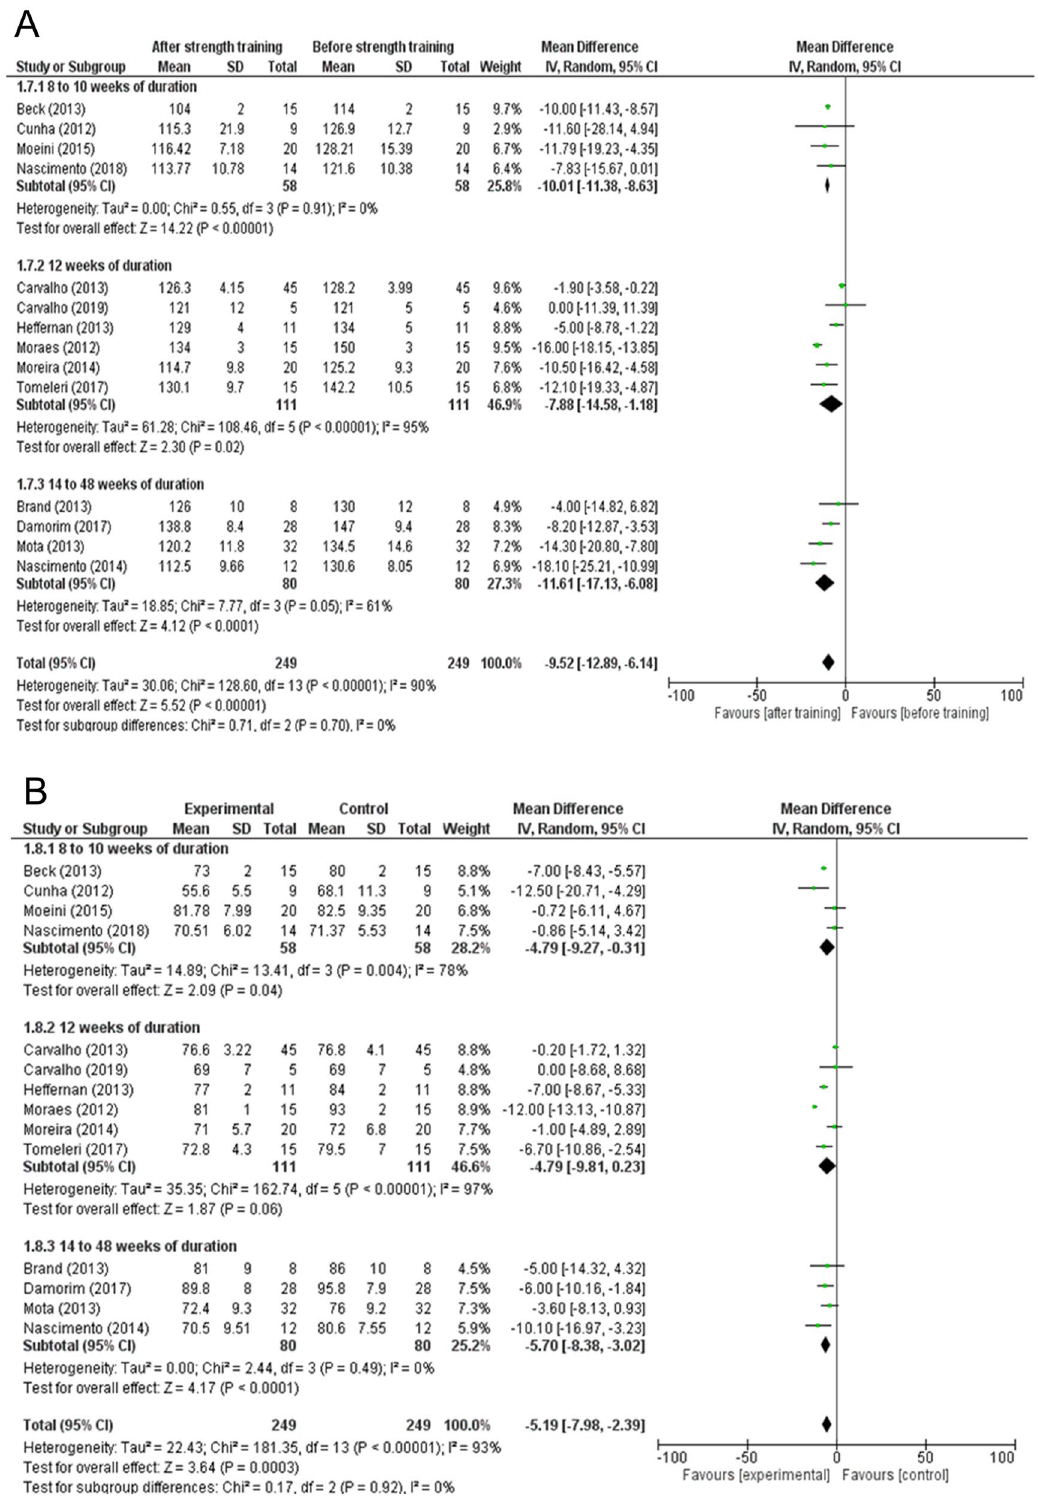
Figure 6. ( A ) Effects of strength training on systolic blood pressure in hypertensive individuals with 8 to 10, 12, and 14 to 48 weeks of training duration. ( B ) Effects of strength training on diastolic blood pressure in hypertensive individuals with 8 to 10, 12, and 14 to 48 weeks of training